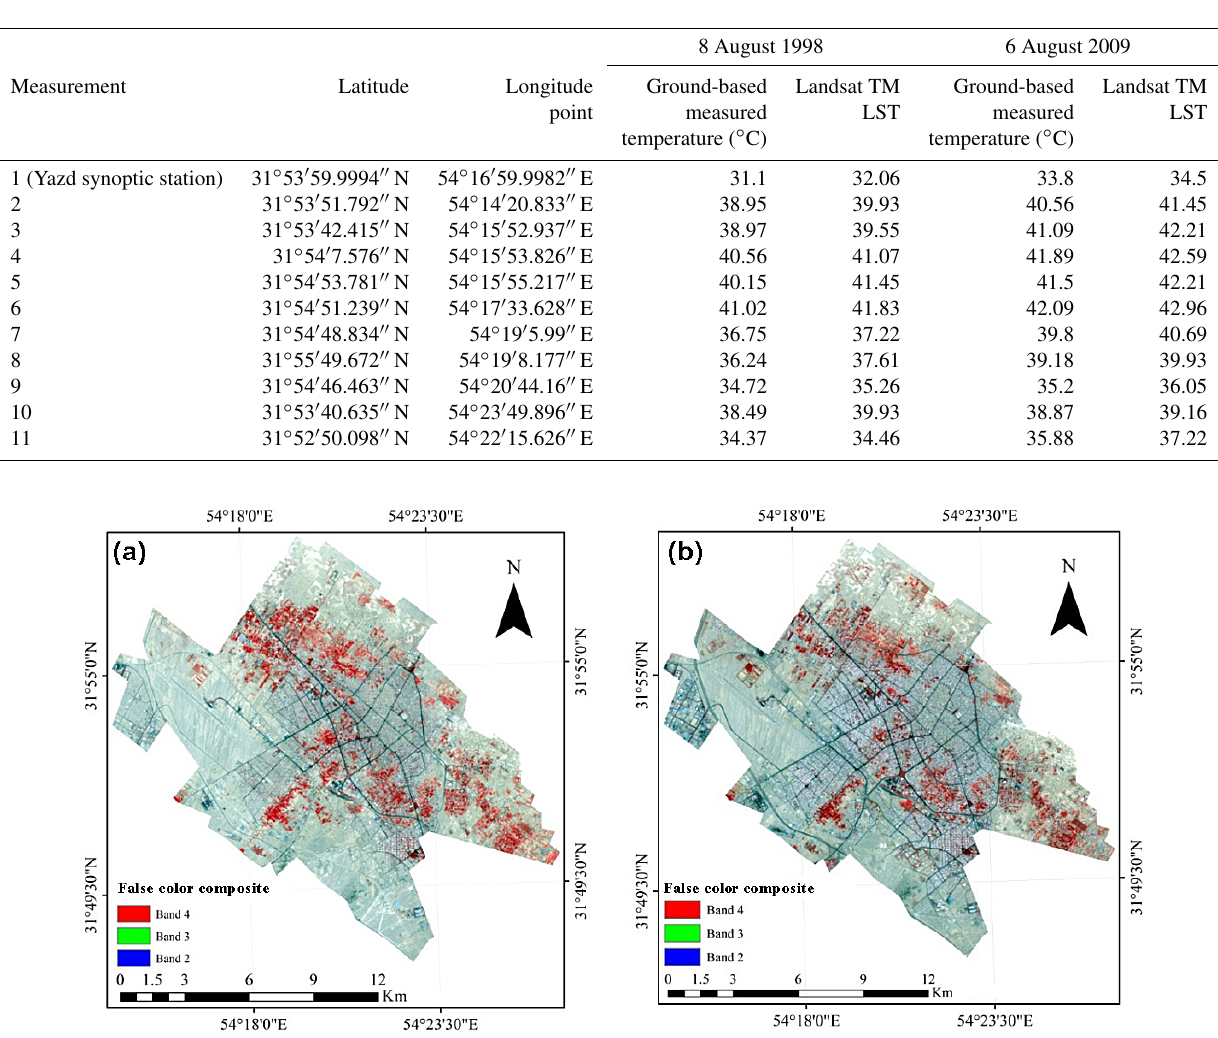
Table 3. Coordinates of the land surface temperature measurement points and their ground-based and satellite temperatures.